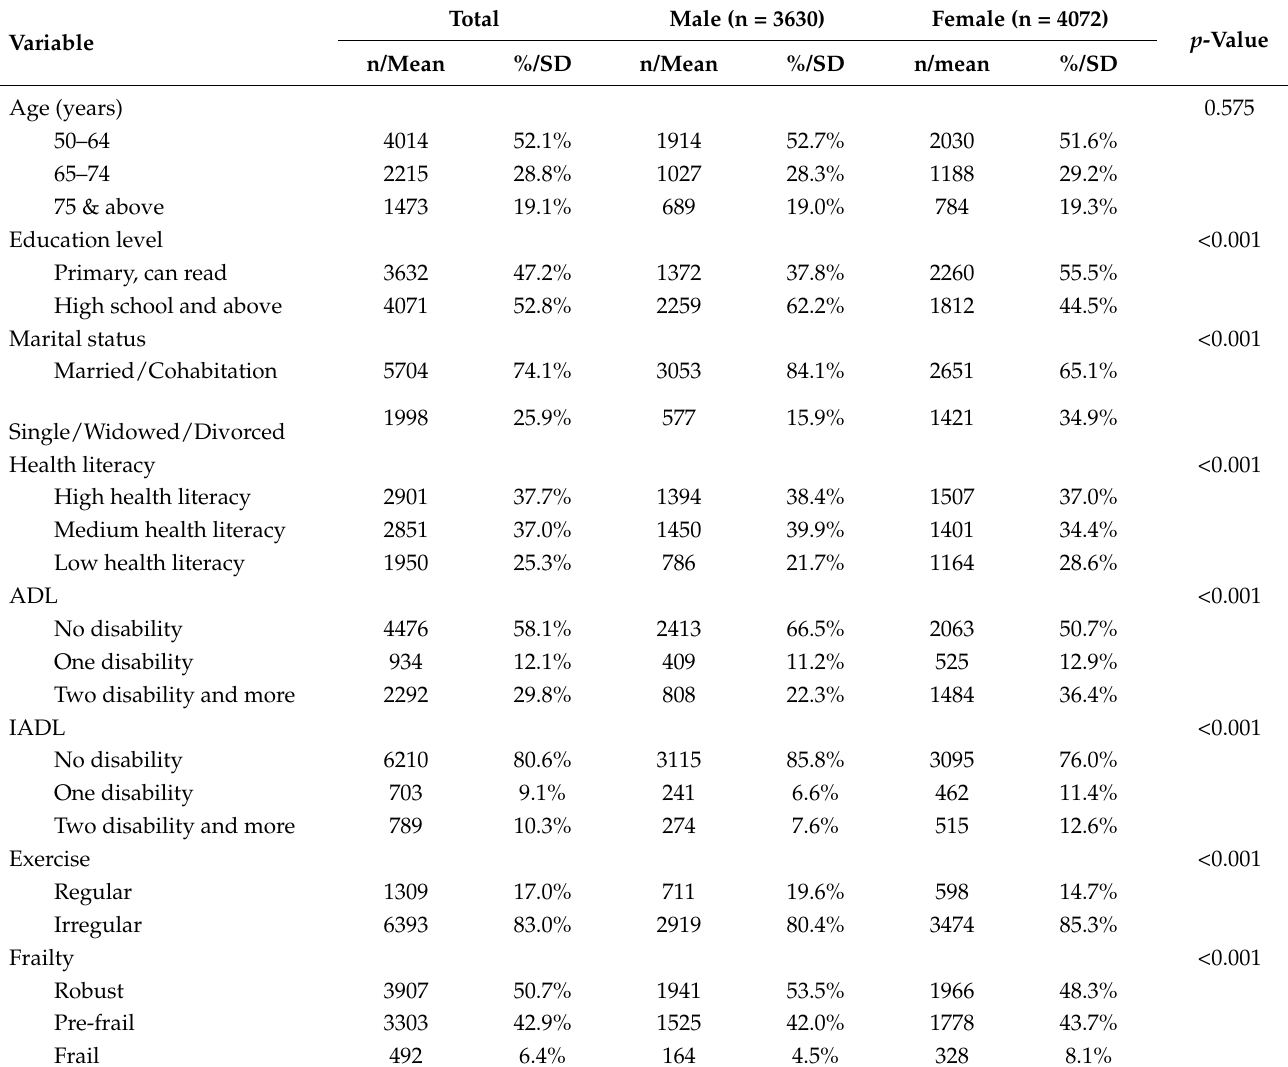
Table 1. Demographic characteristics, disabilities in terms of ADLs and IADLs, exercise habits, and Physical condition of respondents of both sexes ( N = 7702).